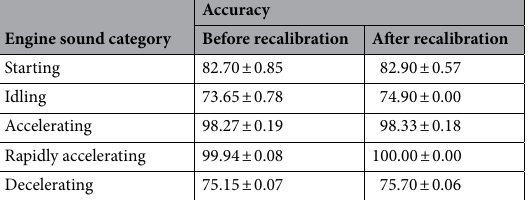
Table 3. Accuracy of engine sound (%) before and after SEB feature